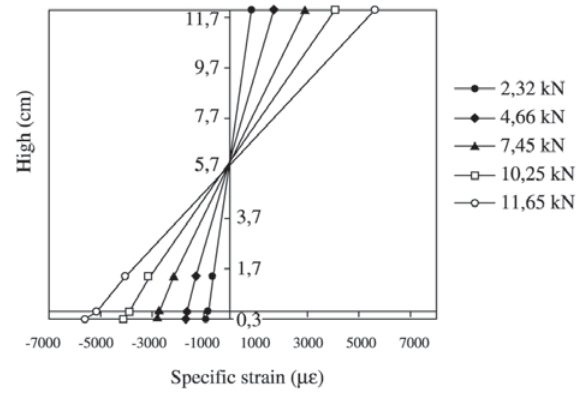
Figure 6. Variation of the strain in cross section - Pinus beam 03 section (6 × 12